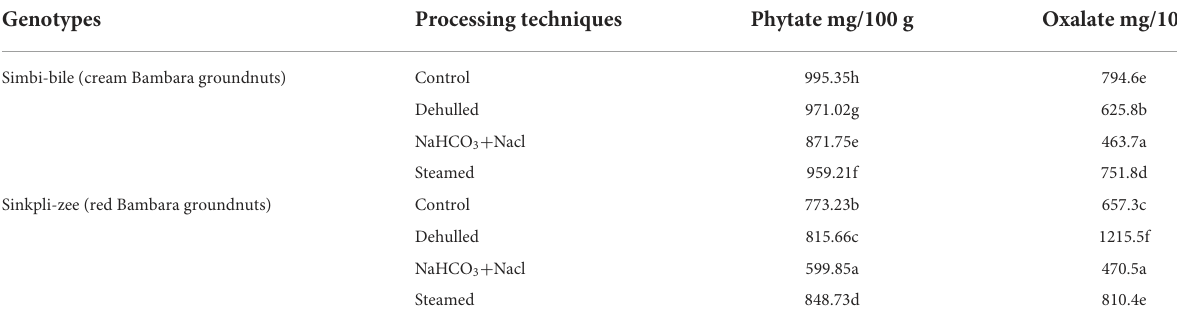
TABLE 3 Effect of processing techniques on the anti-nutritional factors in Bambara groundnuts.